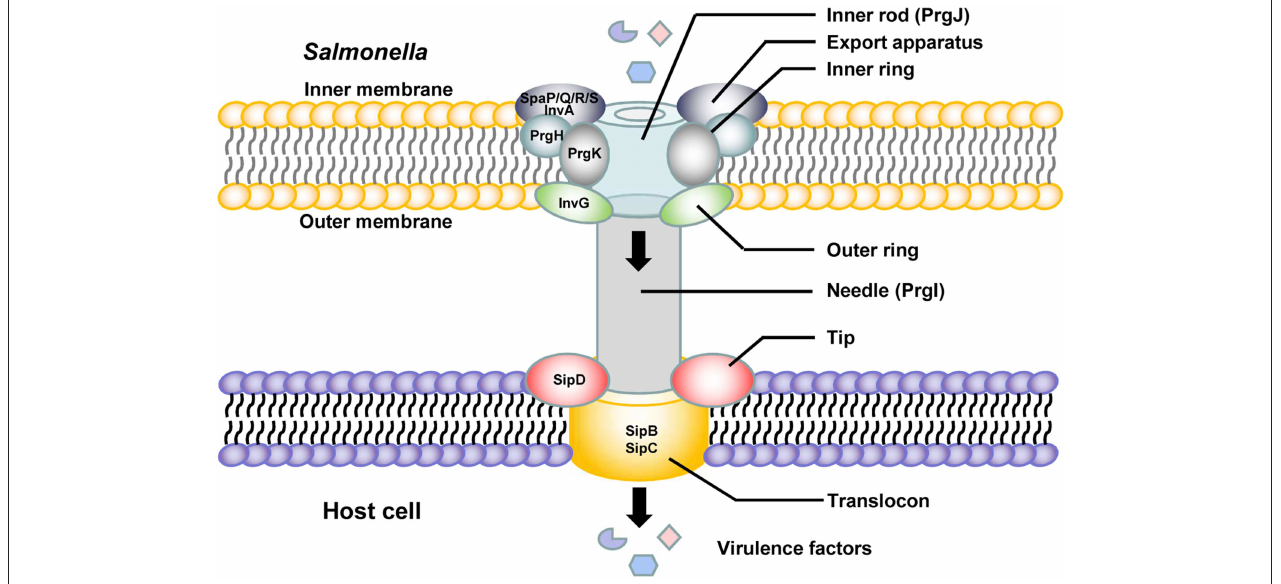
FIGURE 1 | Schematic diagram of the SPI-1-related T3SS needle apparatus in contact with a host